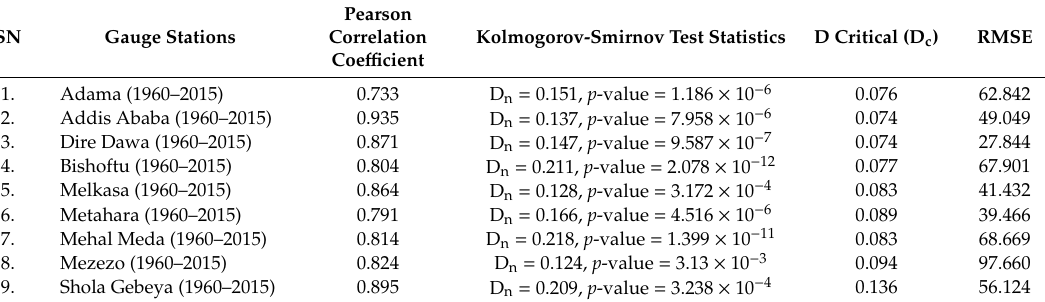
Table 2. Performance of CRU dataset over the gauge stations.